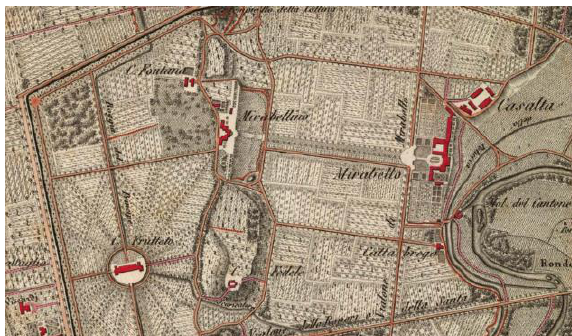
Figure 2. Extract from the Brenna’s map of the Royal Park of Monza: it should be noted the abundance and precision of graphic details and denominations used to describe the territory’s landscape and architectural